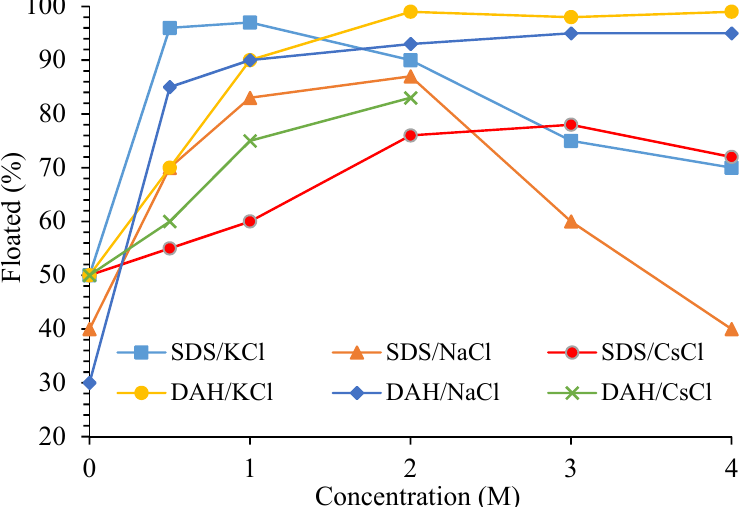
Figure 5. Effect of monovalent salts on colemanite flotation with 4 × 10 − 5 M of anionic (SDS) and cationic (DAH) collectors, pH 9.3 ± 0.1. Colemanite was conditioned in the reagents for 10 min and floated for 1 min [11] .